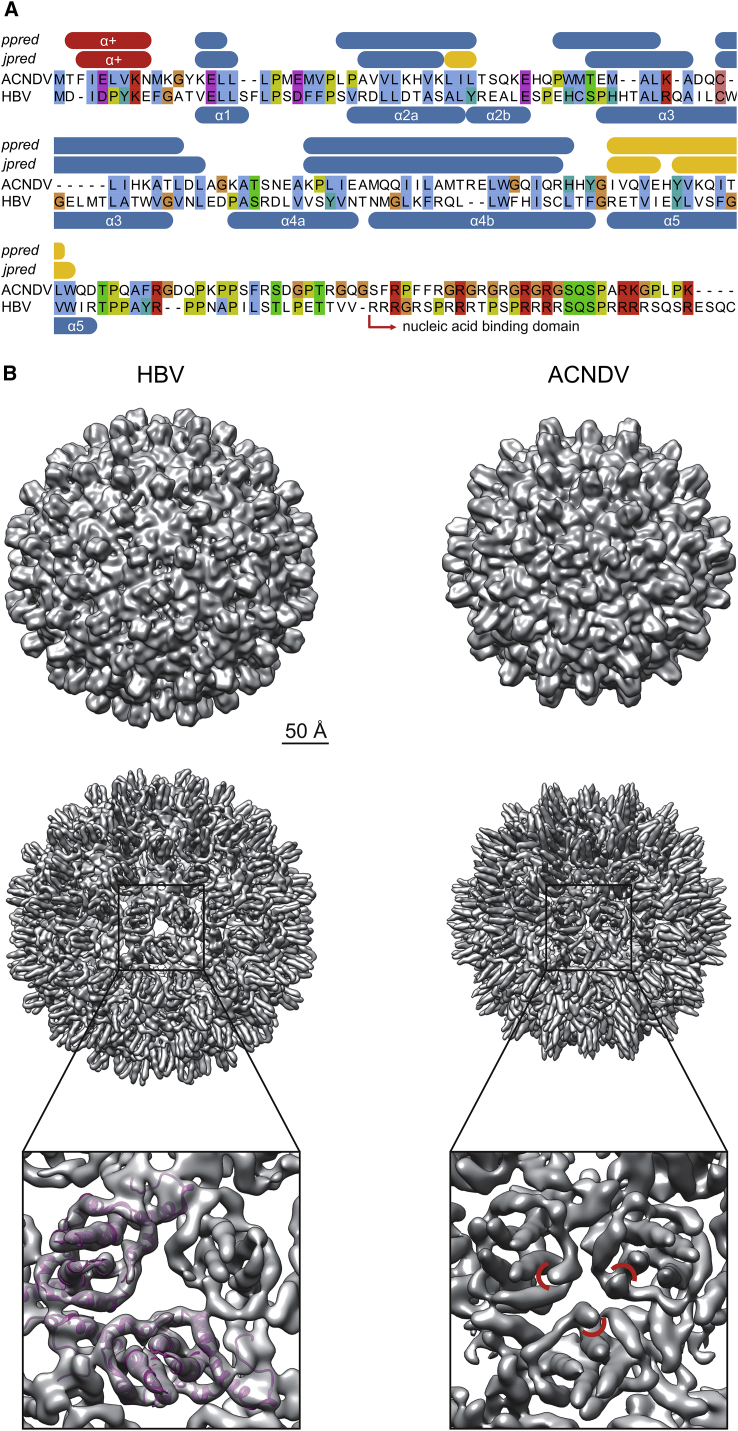
Capsid Ultrastructure(A) Alignment of the C proteins of African cichlid nackednavirus (ACNDV) and HBV. α helices of HBV C indicated in the bottom refer to the crystal structure (Wynne et al., 1999). Secondary structures of ACNDV C predicted with jpred (Drozdetskiy et al., 2015) and psipred (ppred) (Jones, 1999) are given in the top. Blue, α helices; yellow, β sheets; red, additional, N-terminal α helix (α+).(B) Comparison of the capsid structure of HBV (T=4) (Yu et al., 2013) and ACNDV (T=3). Cryoelectron microscopy maps low-pass filtered at 12 Å (top row) and 8 Å (middle row). Bottom row: zoomed view onto a local (pseudo-)3-fold axis. Additional α+ helices in ACNDV highlighted by red arcs.See also Figure S3.